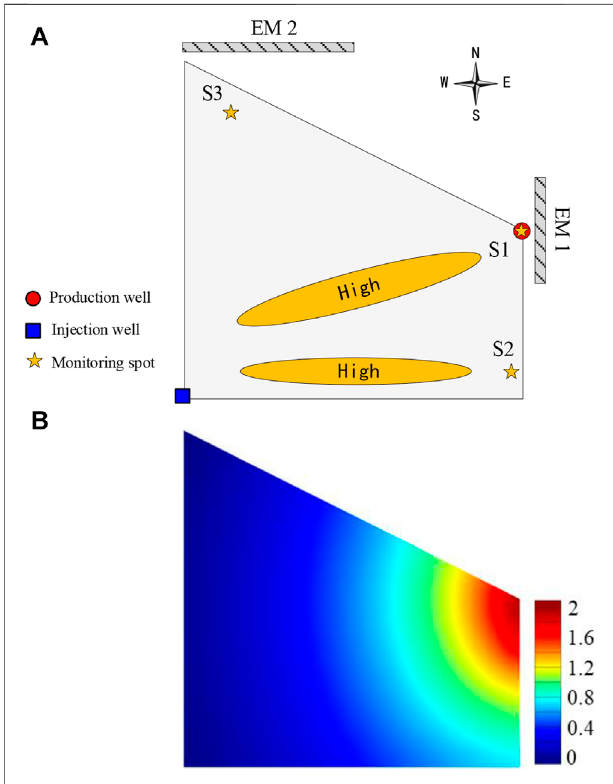
FIGURE 9 | A heterogeneous reservoir model. (A) Model geometry; (B) Distribution of background magnetic fl ux density norm log 10 |B| in units of